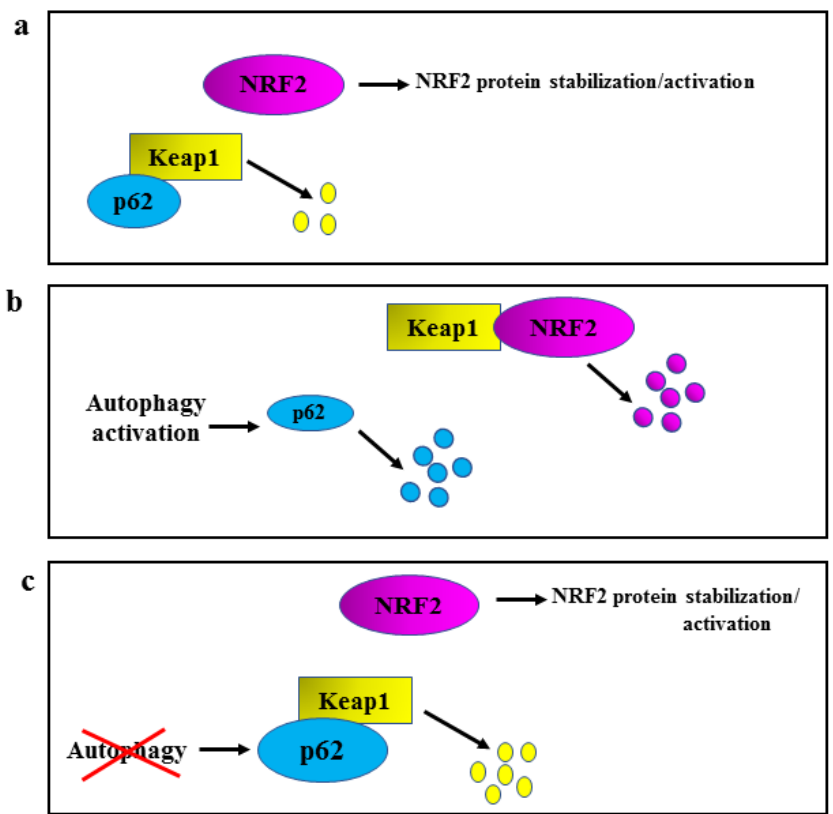
Figure 2. Schematic representation of autophagy/p62/Keap1/NRF2 regulation. ( a ) p62/SQSTM1, herein shortened as p62, triggers a basal Keap1 proteasomal degradation (yellow dots) controlling NRF2 stabilization/activation. ( b ) Autophagy activation degrades p62 (left part, blue dots), stabilizing Keap1 that can bind NRF2 and induce NRF2 degradation (right part, purple dots). ( c ) When autophagy is compromised (red cross), p62 accumulates and can bind Keap1 and trigger Keap1 proteasomal degradation (yellow dots), inducing the stabilization of NRF2.